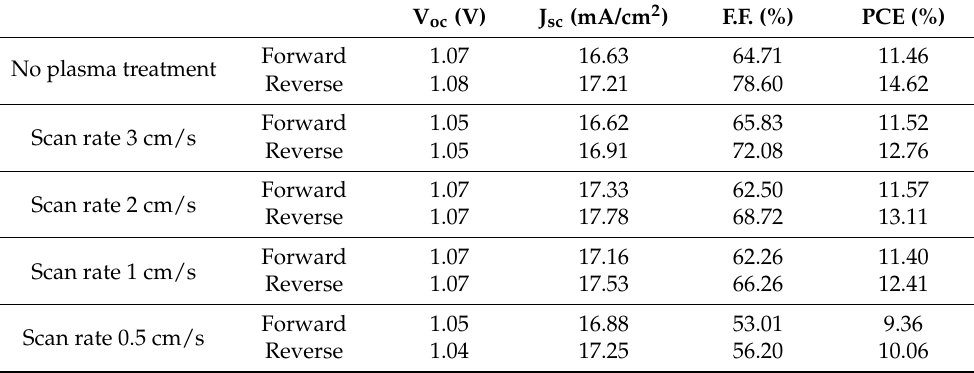
Figure S3: PV parameters of PSCs with He DBDjet treatment on BCP (reverse scan); Figure S4. Cross- sectional view SEM images of the samples. Table S1: EIS fitting parameters; Table S2: PV parameters of PSCs with He DBDjet treatment on